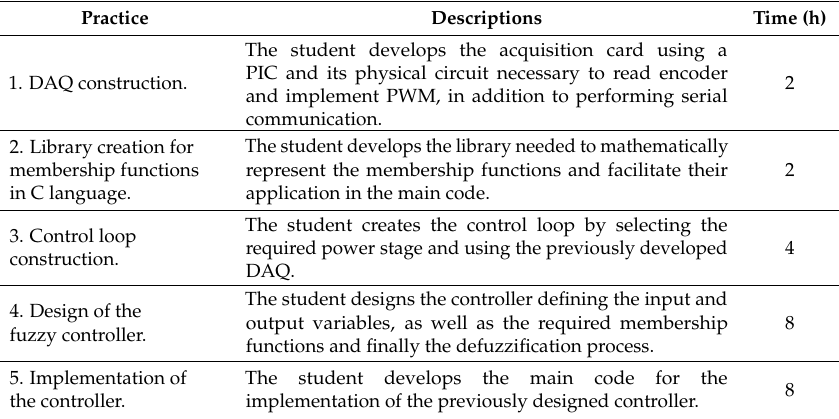
Table 3. Practices required to develop the project.